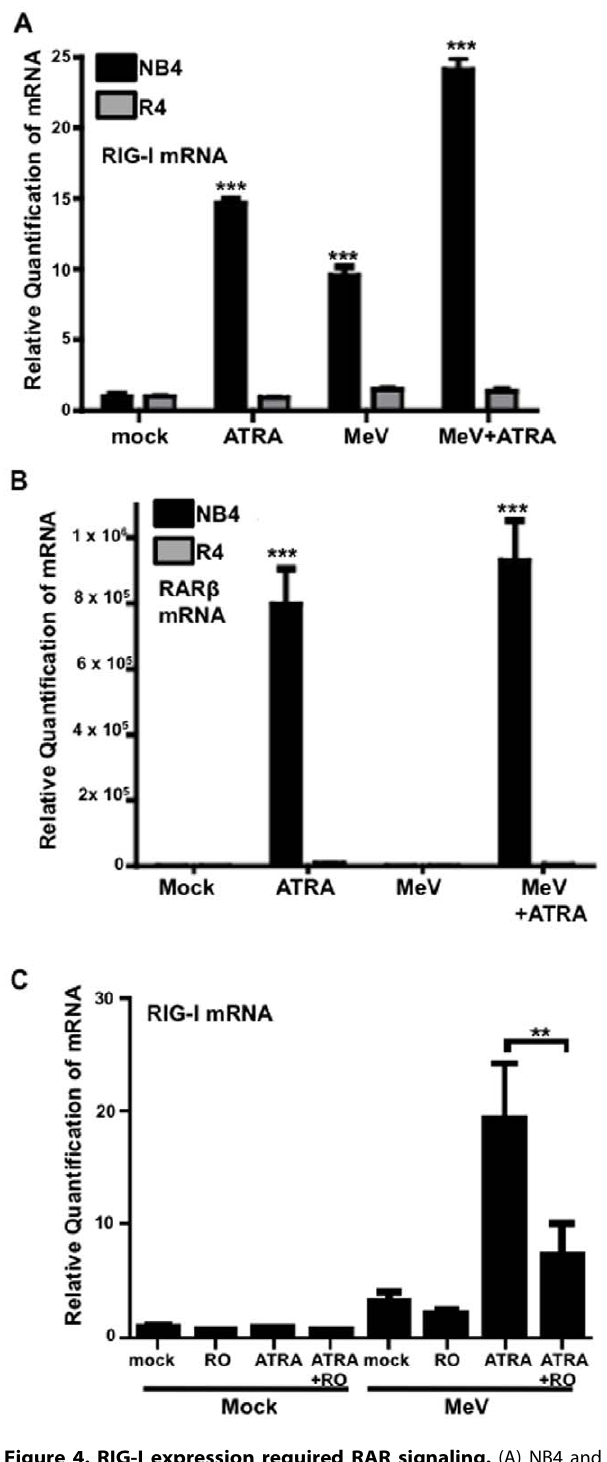
Figure 4. RIG-I expression required RAR signaling. (A) NB4 and R4 cells were infected with MeV at an MOI of 0.01, treated with 1 m M ATRA or DMSO and/or treated with 1000 U/mL IFN b . After 48 hours, samples were harvested and analyzed for RIG-I expression and (B) RAR b expression by qPCR. Data presented are representative of two experiments performed in triplicate (N=2). (C) U937 cells were infected at an MOI of 0.1 for 24 hours in the presence of 10 nM ATRA and/or 1000 nM of the RAR a -selective antagonist RO 41-5253 (RO). Samples were analyzed for RIG-I expression by qPCR. Data presented are representative of three experiments performed in triplicate (N=3). **p , 0.01, ***p , 0.001.